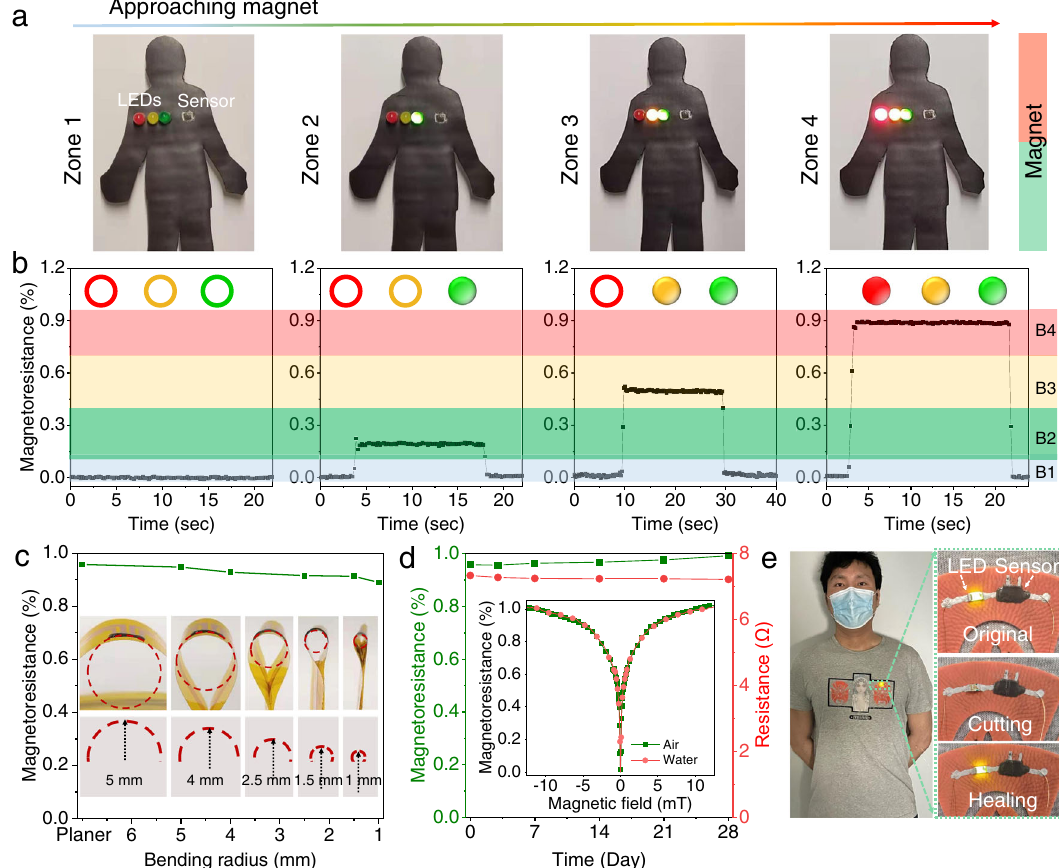
Fig. 4 | Wearable printable magnetoresistive sensor mounted onto garments forsafetyapplication.a , b Indicatorofmagnetic fi eldsforpatientsimplantedwith magnetic fi eld sensitive devices (e.g., cardioverter de fi brillator and pacemakers). a Photograph of humanoid model decorated with green, yellow, and red LEDs controlled by magnetoresistance signal of sensor. As approaching a permanent magnet,thesensorenteredintoZone1 – 4andtriggeredLEDsonone-by-onedueto the intensi fi ed magnetic fi eld. b Four bands (B1 – B4) of magnetoresistance